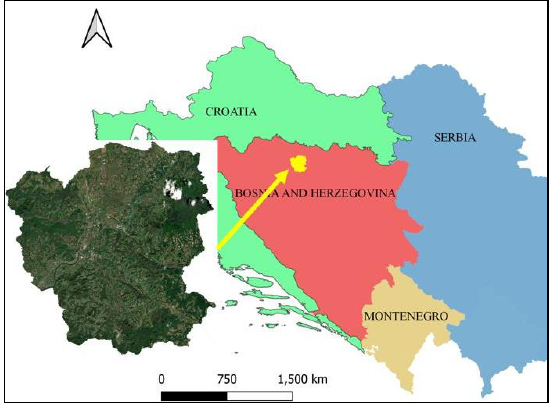
Figure 1 . The position of Laktaši municipality The two sets of data: manually vectorized data with orthophoto images of LC/LU and CLC were compared in this paper. The reason for this comparison is the fact that those ortophoto images dates from 2018, which is the same as baseline year of CLC for BIH.